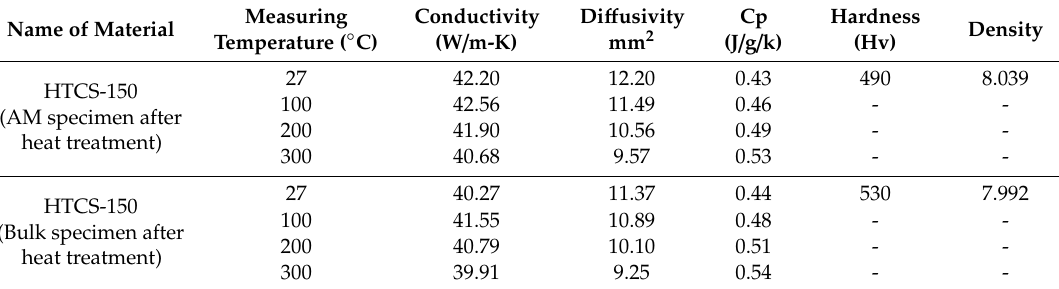
Table 6. Thermal conductivity and surface hardness of HTCS-150 with heat treatment.